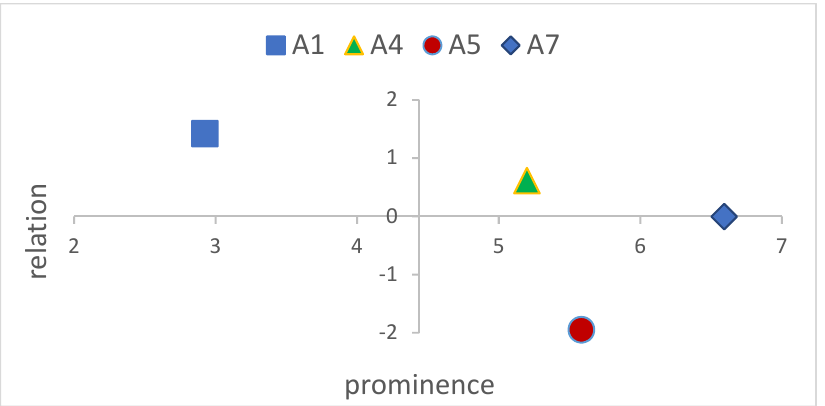
Figure 9. Results for the limited set of factors; the total influence T case.